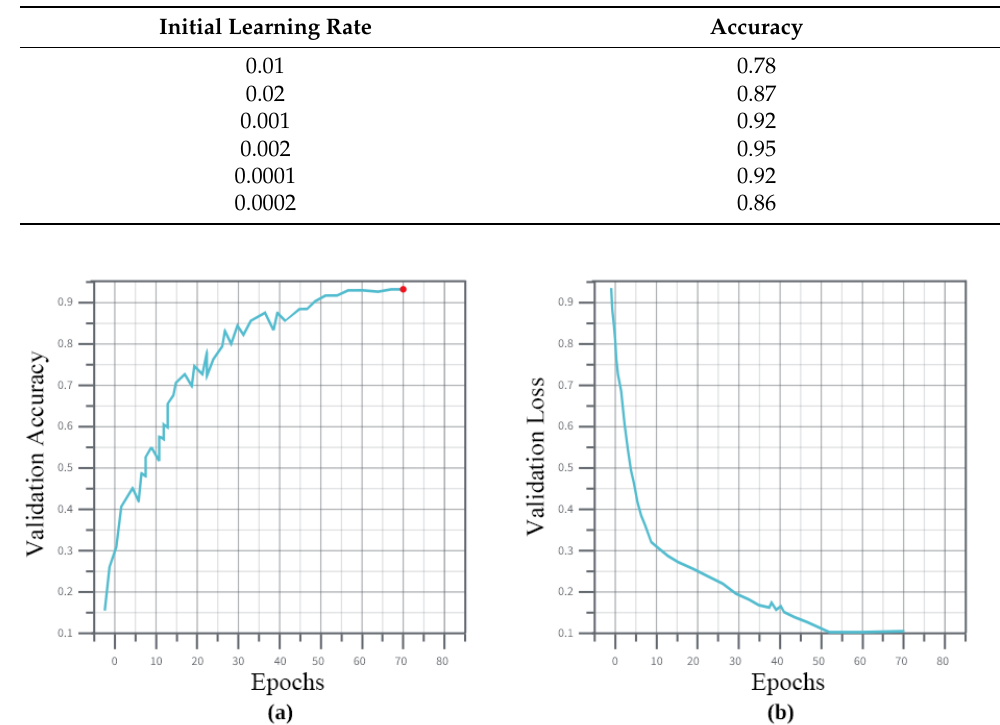
Figure 10. Impact of different epochs on the efficiency of proposed model. Table 3. Impact of different Learning rates on the efficiency of proposed model.